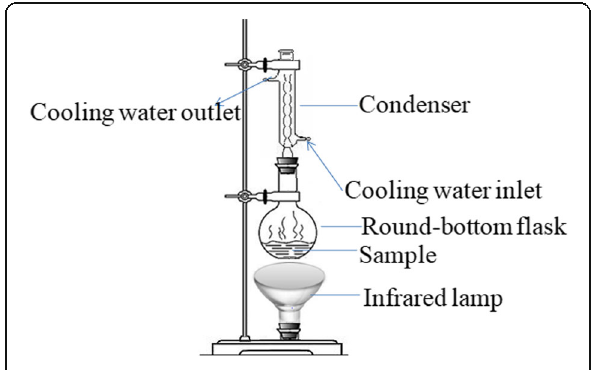
Fig. 2 The apparatus of IRAE (drawn by